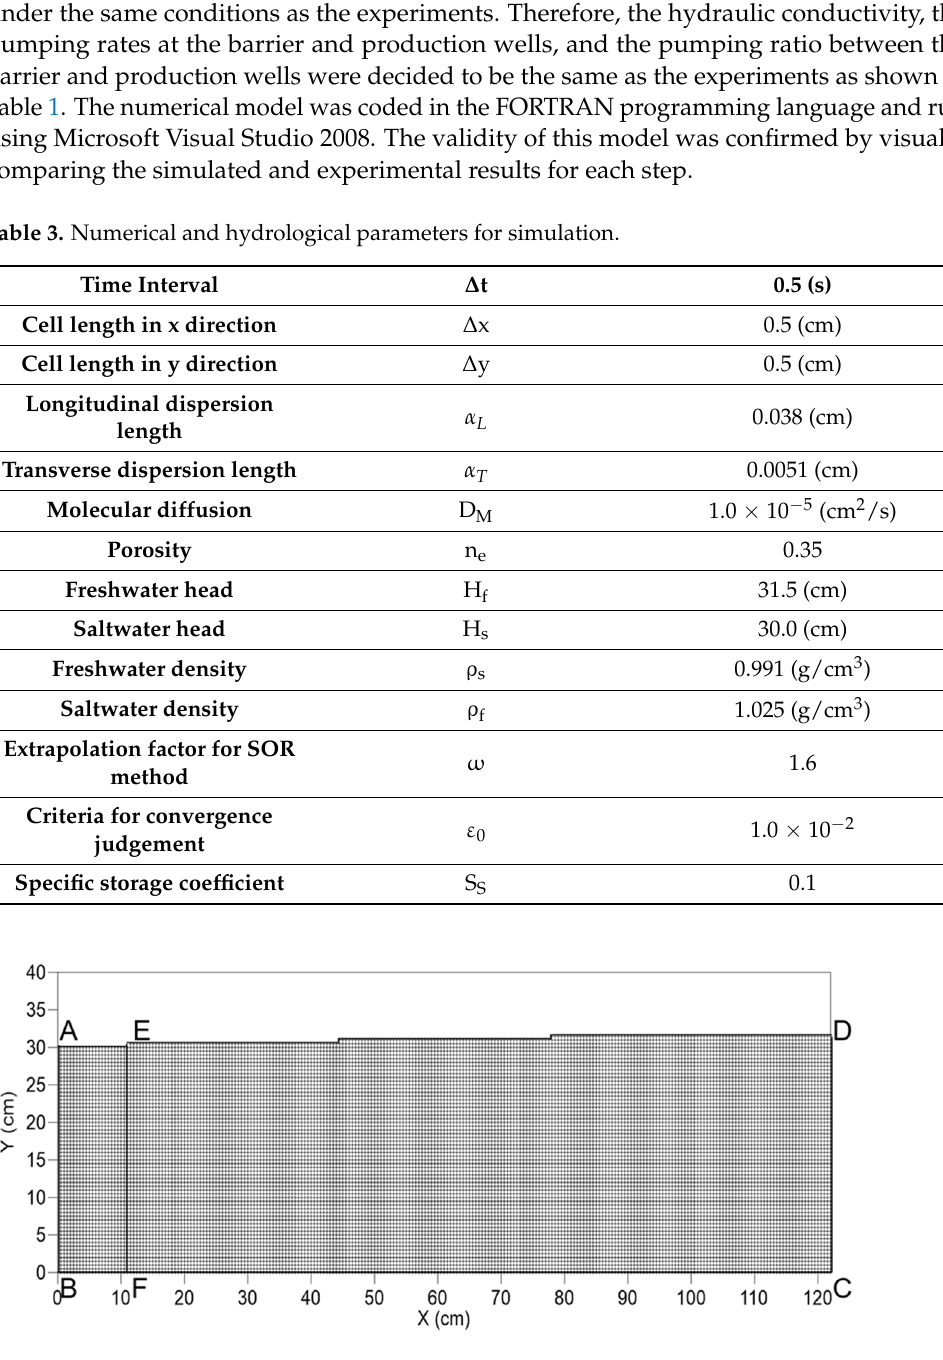
Figure 4. Numerical model and boundaries. Table 4. Boundary conditions.